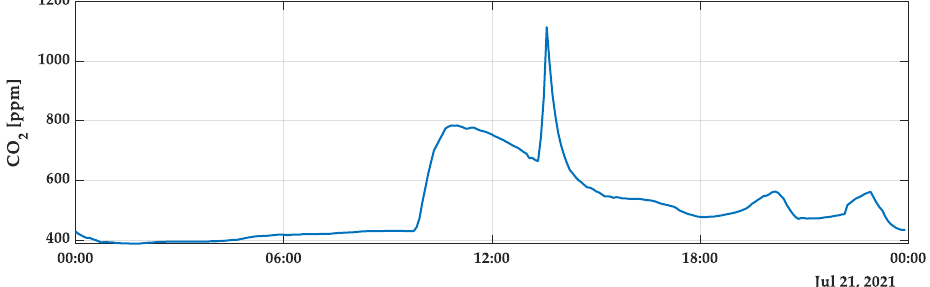
Figure 35. Records of air temperature. Figure 36. Records of relative air humidity.